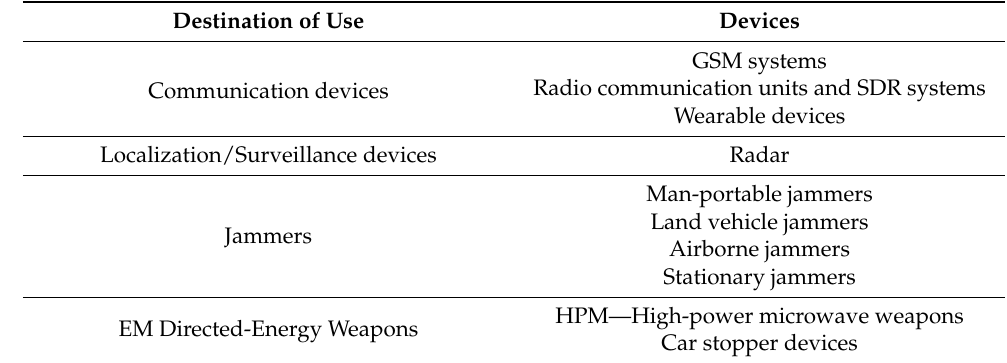
Table 1. Military devices grouped by intended